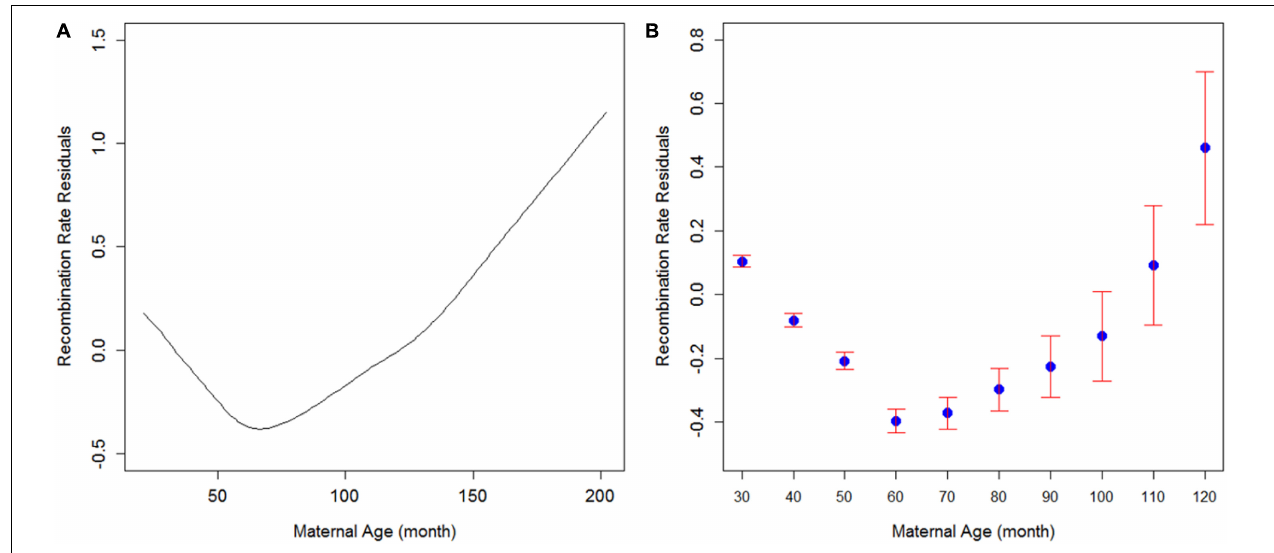
FIGURE 1 | Trend of recombination rate residuals against maternal age in cattle. (A) Fitted smooth spline of recombination rate residuals along with maternal age. The smooth spline was fitted in R using the smooth spline function between recombination rate residuals and maternal age. (B) Recombination rate residuals in different maternal age groups. Blue dots are means, and bars are standard